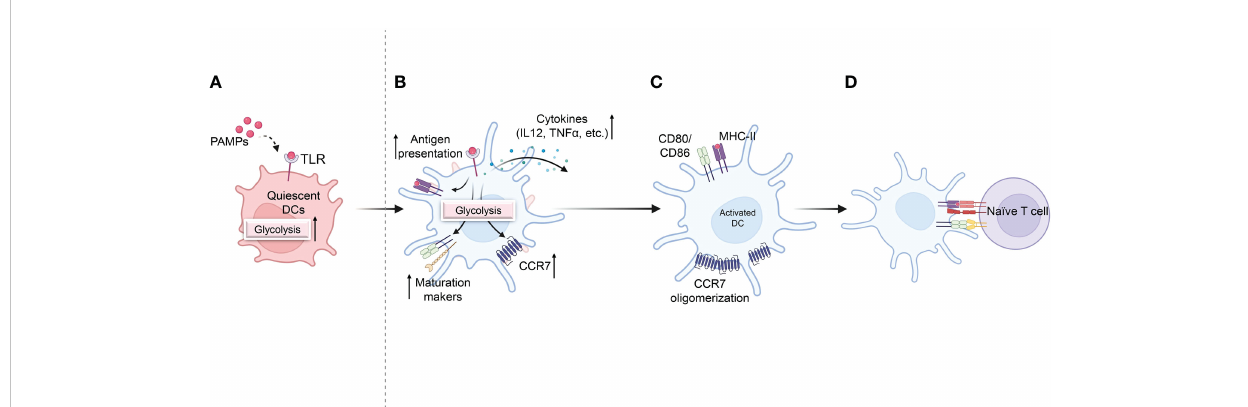
FIGURE 3 Effect of glycolysis on DC activation and pro-in fl ammatory activity. (A) Quiescent DCs recognize pathogen-associated molecular patterns (PAMPs) that are required for DC maturation, along with a rapid increase in glycolysis. (B) Increased glycolysis increases DC activation and antigen presentation after TLR activation. (C) Glycolysis also promotes the migration of activated DCs by stimulating CCR7 oligomerization. (D) Activated DCs in lymph nodes express co-stimulatory markers, initiating T-cell priming